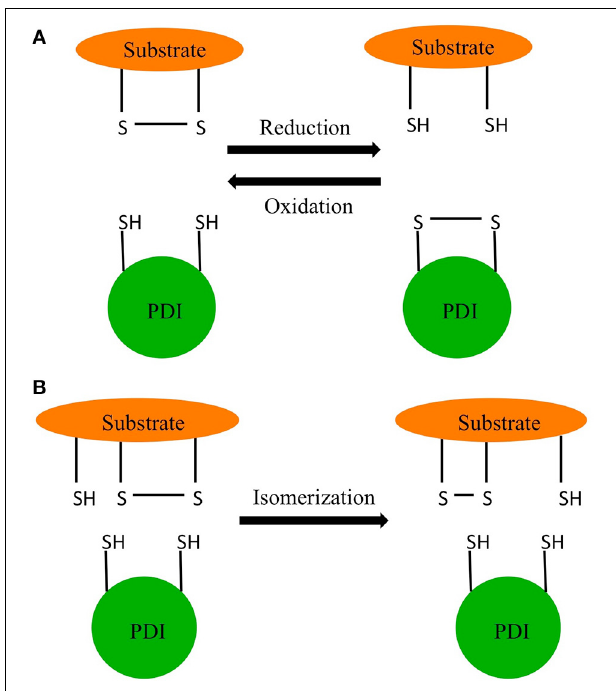
FIGURE 1 | Redox reactions of PDI. (A) Oxidation and reduction. (B)